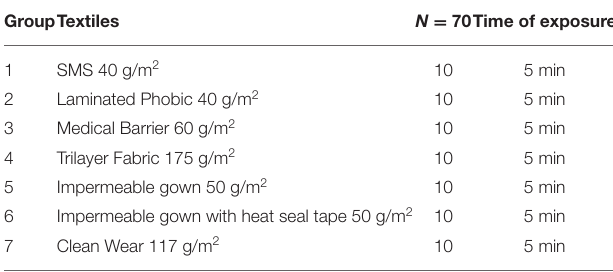
TABLE 1 | Characteristics of test